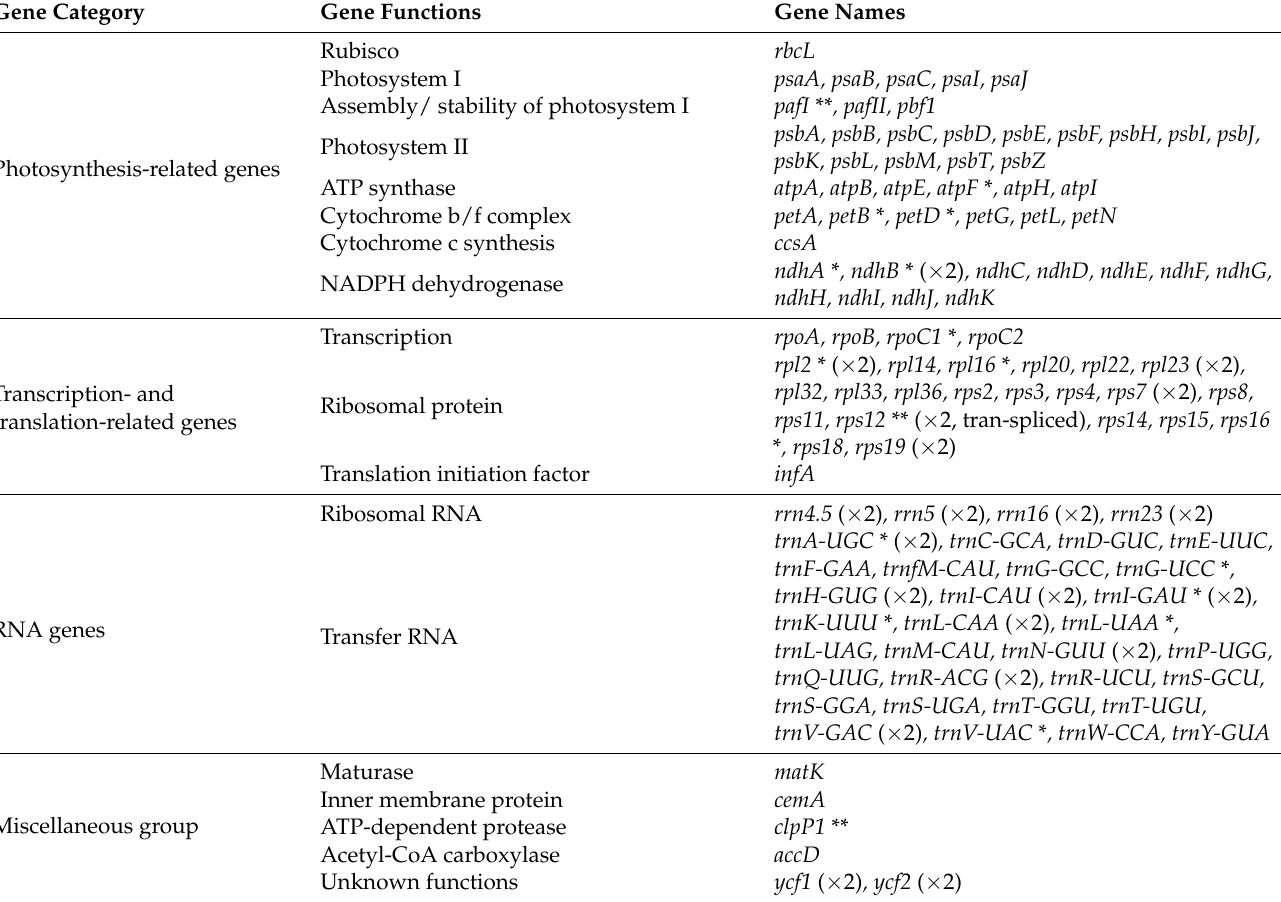
Table 3. Genes annotated in the chloroplast genomes of the studied nine